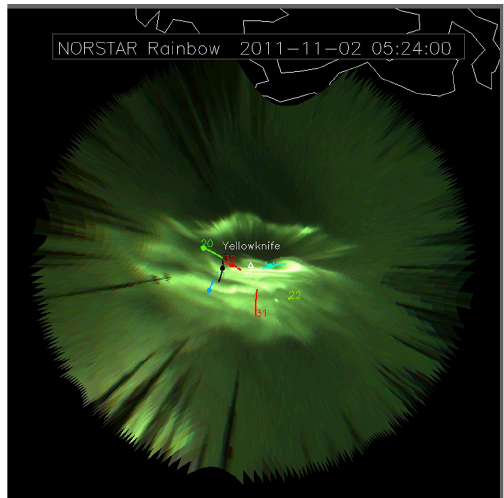
Fig. 7. The auroral emission during an auroral breakup mapped on a geographic grid. The IPPs for GPS satellites at elevation angles above 30 ◦ are superposed for one hour starting at 05:00UT. The altitude of 110km is assumed for both the auroral emission and IPPs. The dots show IPPs at the time when the image was taken, provided that DPR exceeded 4mms − 1 . The PRNs are shown and colour-coded as in Fig. 8.